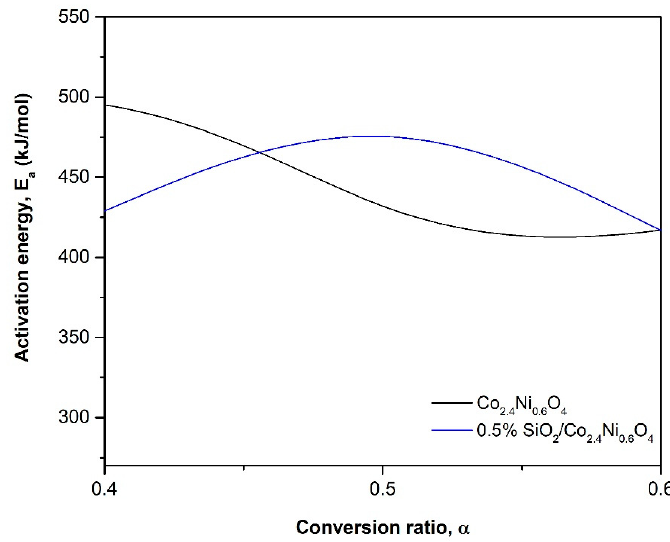
Figure 4. Evolution of the activation energy ( Ea ) with the reduction conversion ratios ( α ).